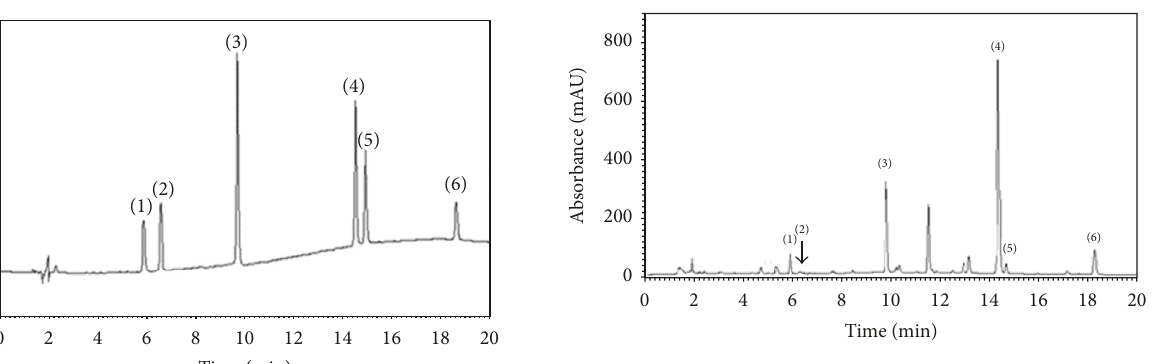
Figure 2: LC-UV/DAD chromatogram relevant to the analysis of a soybean flour sample extract. Peak legend: (1) daidzin, (2) glycitin, (3) genistin, (4) daidzein, (5) glycitein, and (6)